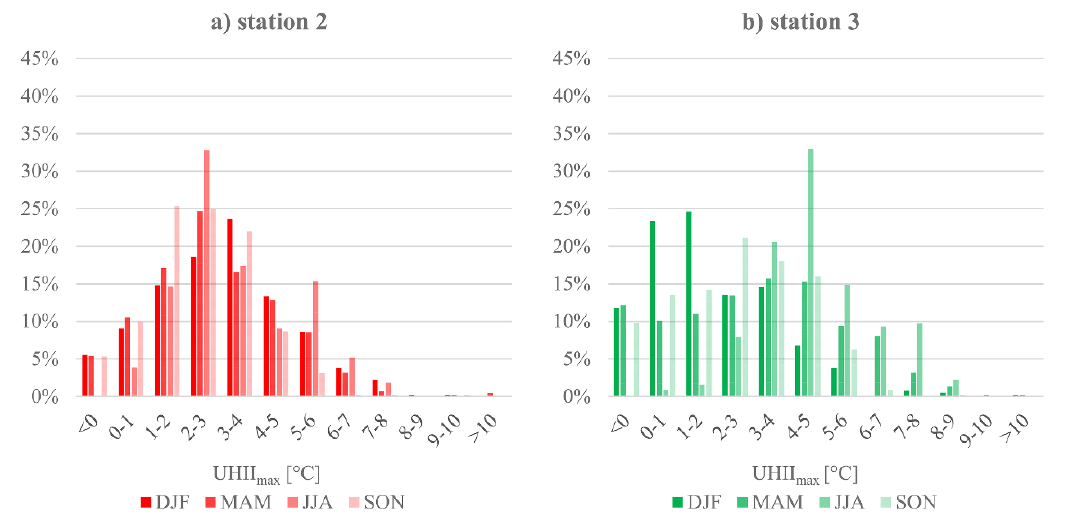
Figure 7. Seasonal distribution of daily values of maximum hourly difference of temperature recorded during each day (UHII max ) at ( a ) stations 2 and ( b ) 3.